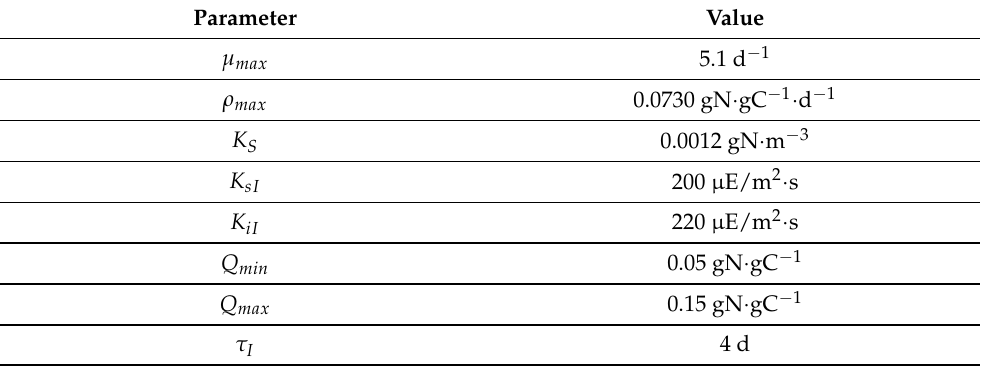
Table 2. Model parameter